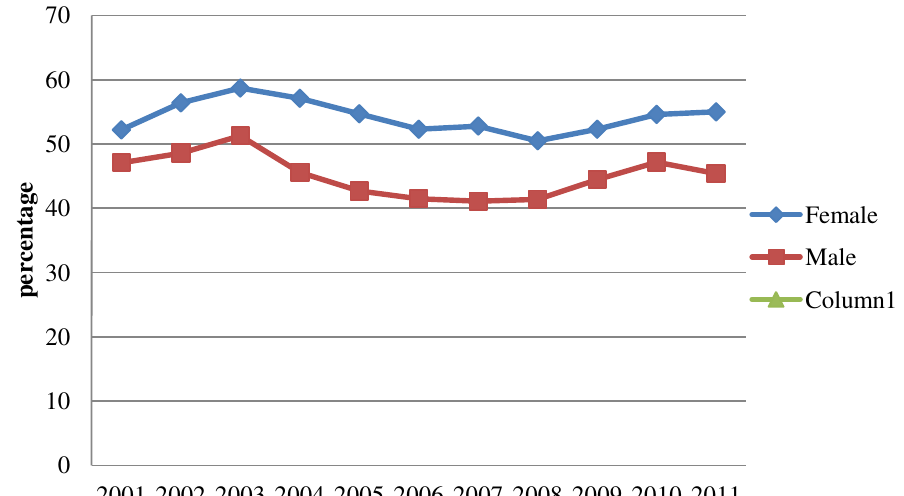
Fig. 2. Unemployment rate by gender (15-24 years), SA, 2001 -2011 Source: SADC Statistical Yearbook (2011)